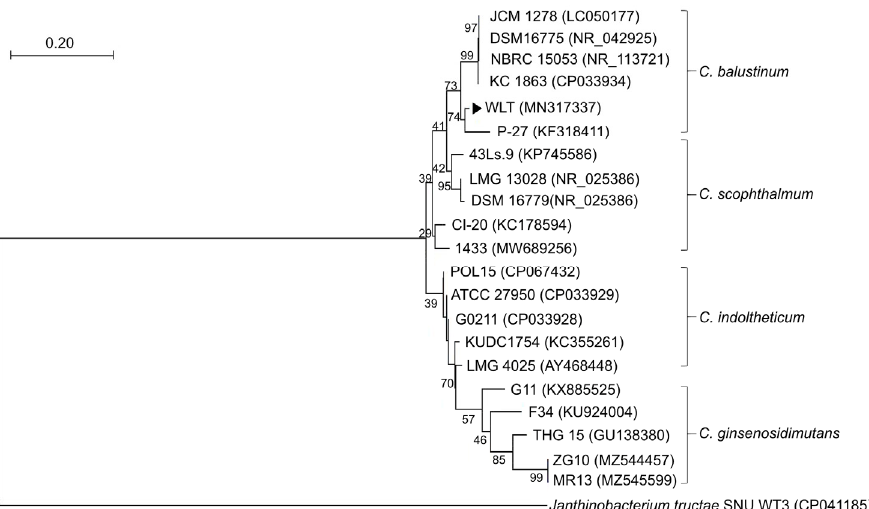
Figure 2. Phylogenetic tree constructed using 16S rRNA gene sequences of the 20 Chryseobacterium species and strain isolated in this study. The tree was constructed by MEGA X using the neighbor- joining method with a bootstrap analysis of 1000 replicates. (Genbank accession number: MN317337).